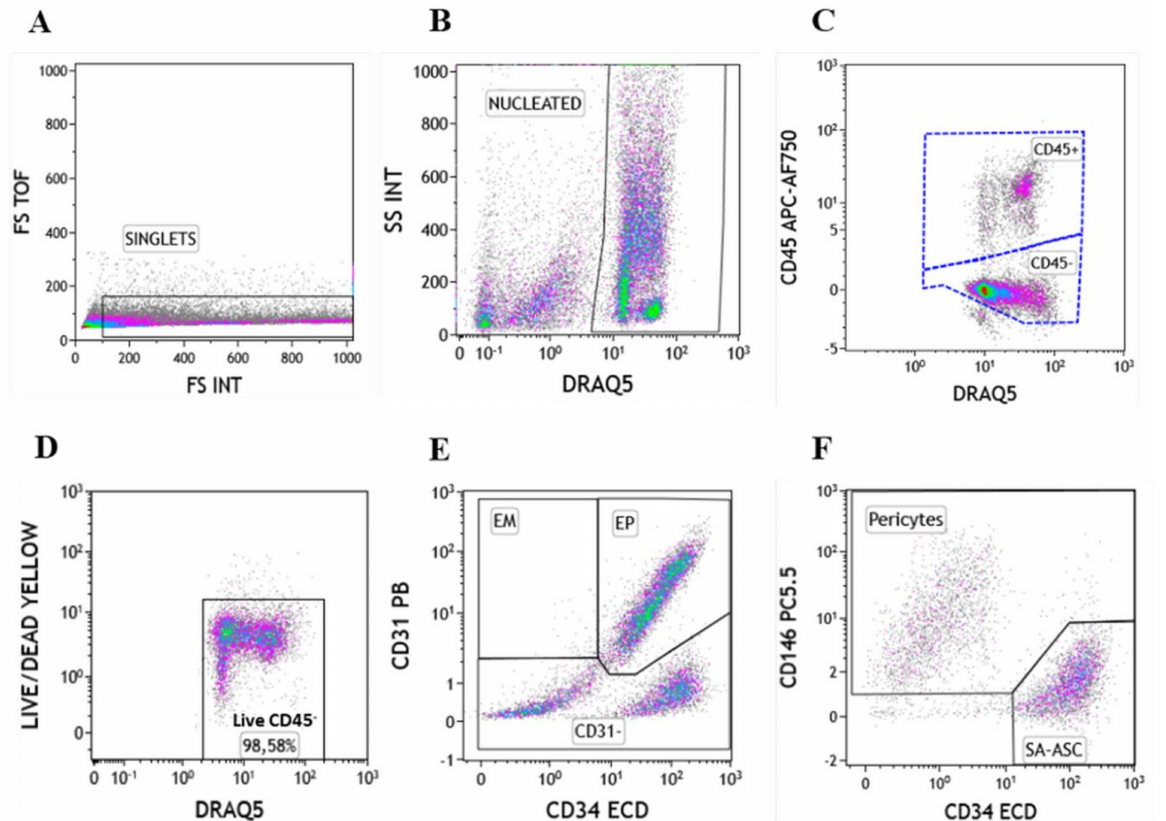
Figure 1. The gating procedure for the polychromatic flow cytometry analysis of heterogeneous cell content in the stromal vascular fraction from lipoaspirate, microfragmented lipoaspirate and concentrated stromal vascular fraction samples. Singlet events based on forward scatter (FS) intensity (INT) and FS time of flight (TOF) ( A ) and nucleated cell events selected by the DNA–binding DRAQ5 dye–positivity and side scatter (SC) INT ( B ) were used to analyze the CD45 + and CD45 − cell populations ( C ), the viability of which was determined based on the Live/Dead Yellow staining ( D ). Nucleated live CD45 − cells were phenotyped using the CD31 and CD34 lineage markers, such as CD31 + CD34 − endothelial mature (EM), CD31 + CD34 + endothelial progenitor (EP) and CD31 − non–endothelial population ( E ), which was in combination with the CD146 marker further phenotyped as pericytes and supra–adventitial–adipose stromal cells (SA-ASC) ( F ). Using this gating strategy, we determined the phenotypes of the CD45 − subpopulation in